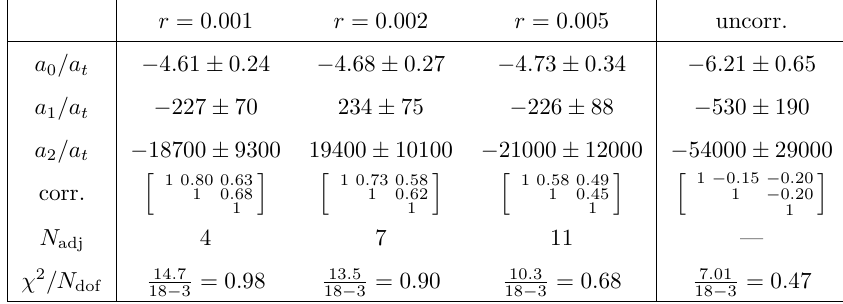
Table 13 . As table 11 but for D ¯ K I = 1 on the m π = 239 MeV ensembles, eq.